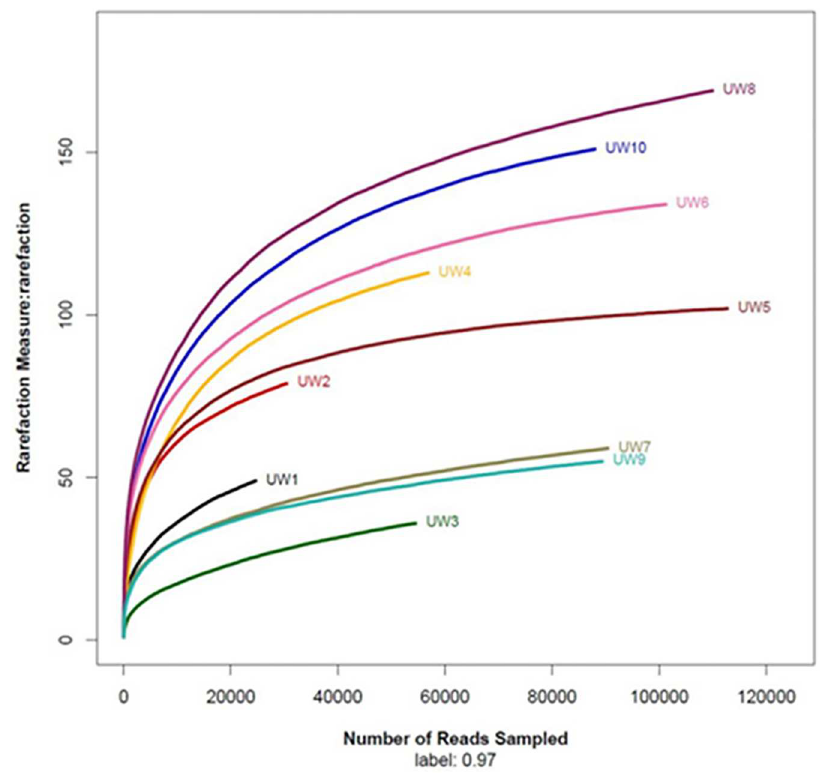
Fig 1. Rarefactioncurves of the OTU number at 97% similarity for each sample